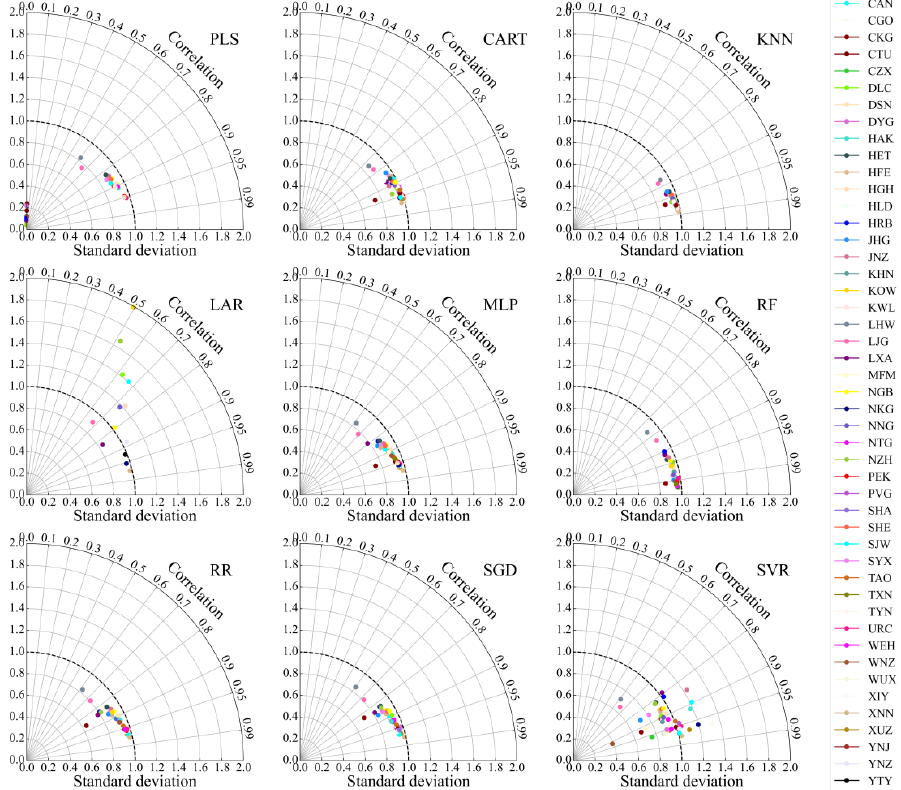
Figure 7. Taylor diagram presents a comparison of the hourly predicted and observed airport visibility in the training period (2018 – 2019). The diagram shows the correlation (the arc coordinate) and ratio of the standard deviation between the hourly predicted and observed (Abscissa and ordinate). Except that the standard deviation ratios between standard deviations of the pre- dicted and observed of LAR and SVR methods is discrete around 1, the ratios of other models are concentrated around 1, which shows that most models are well trained and universal for all international airports. In general, RF show the better estimation results from the root mean square error (RMSE) and the mean absolute error (MAE) (Figure 8).